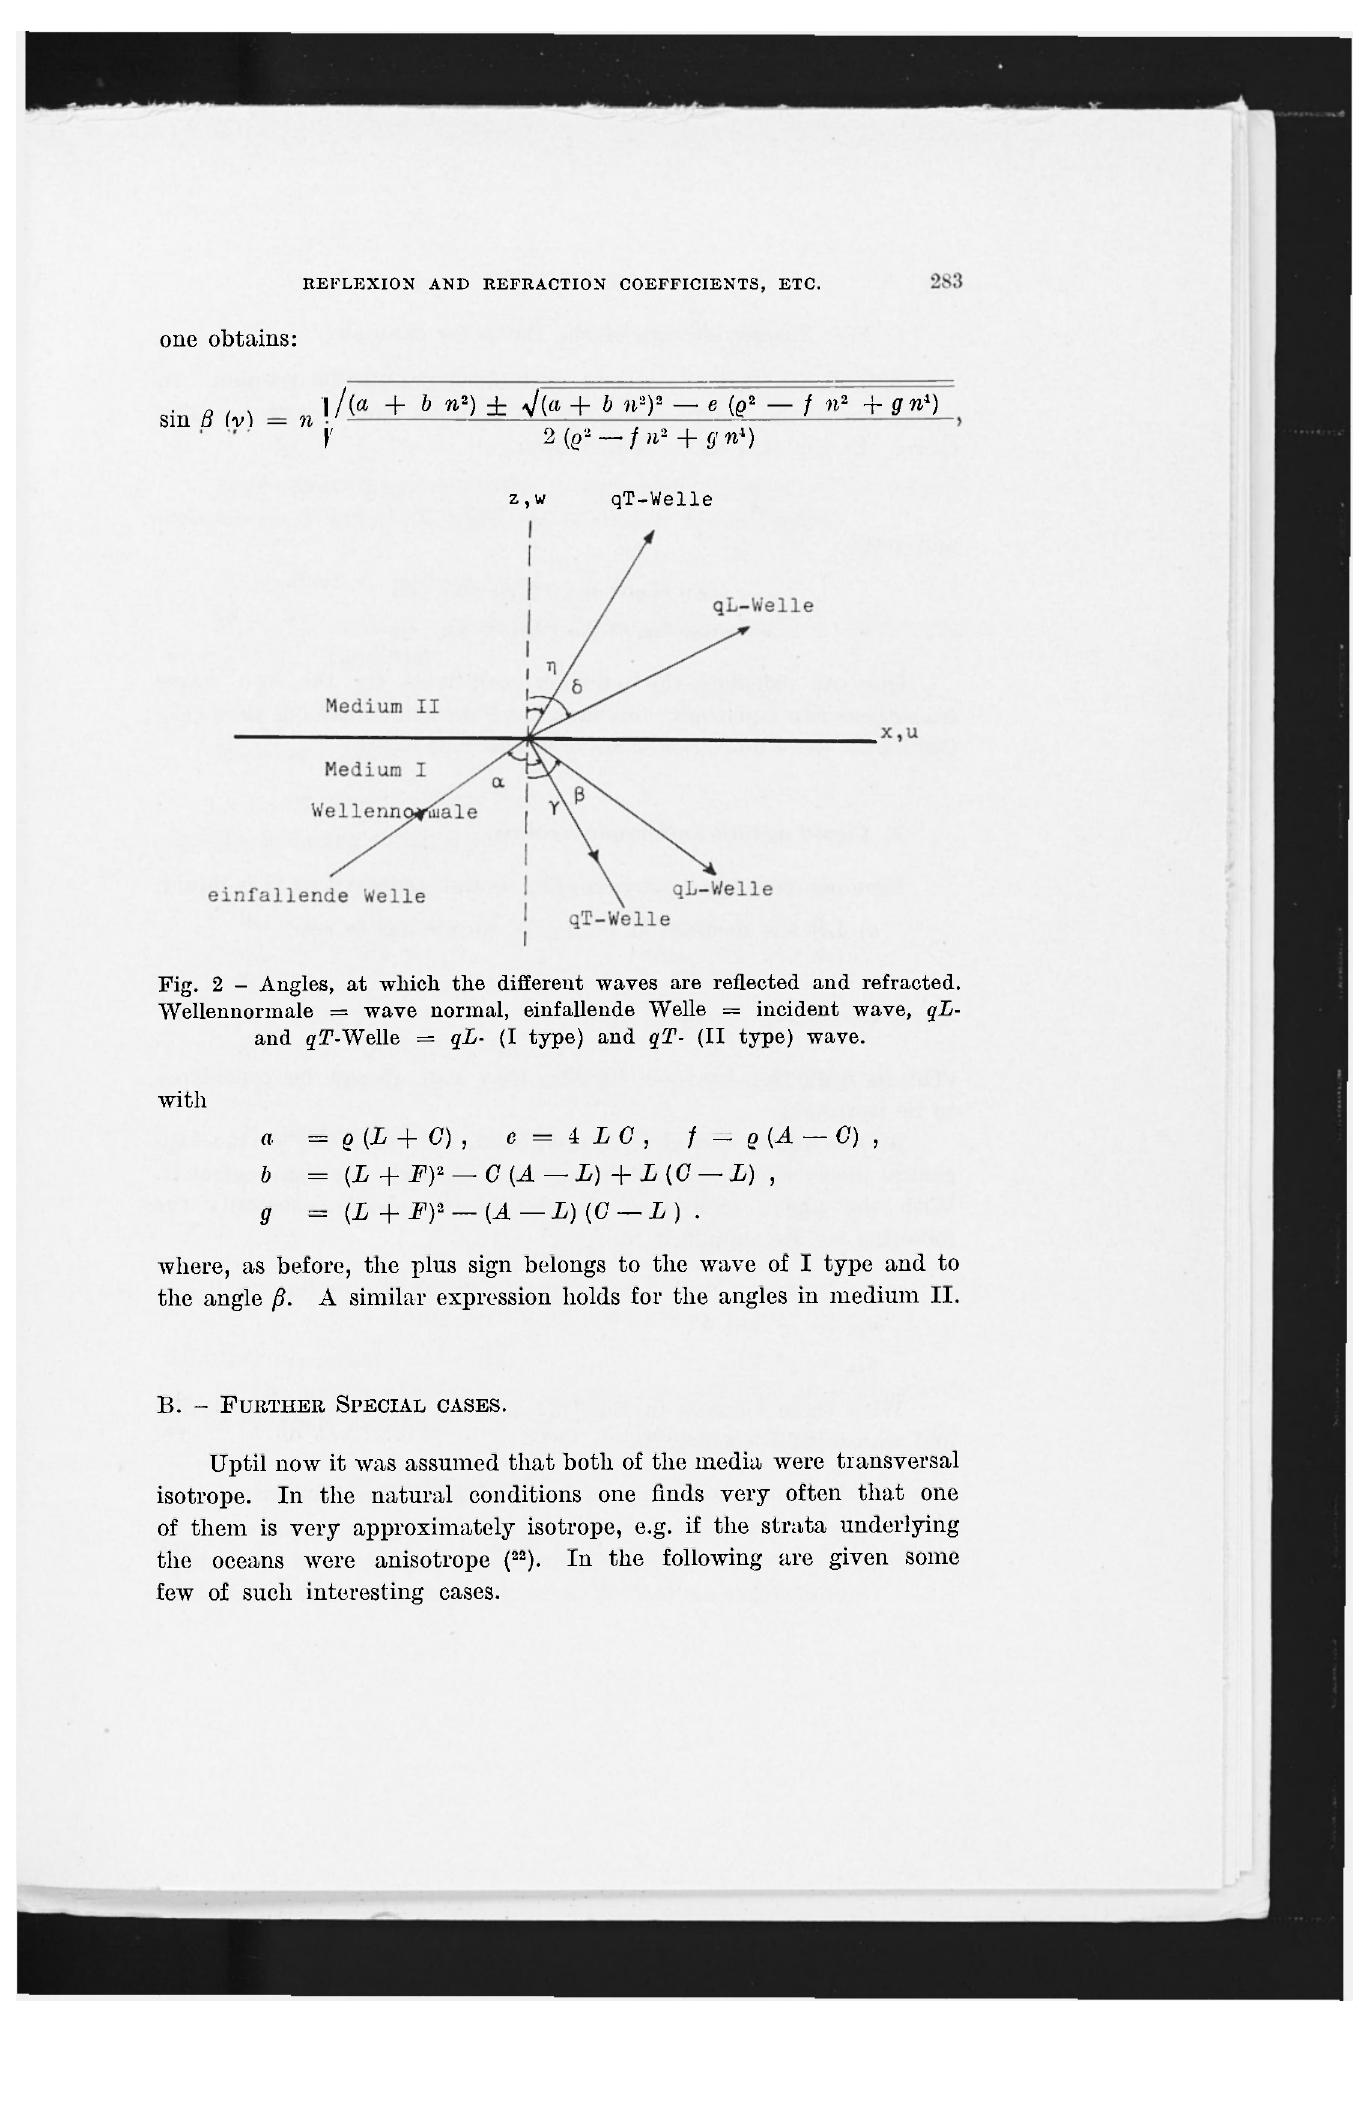
Fig. 2 - Angles, at which the different waves are reflected and refracted. Wellennormale = wave normal, einfallende Welle = incident wave,